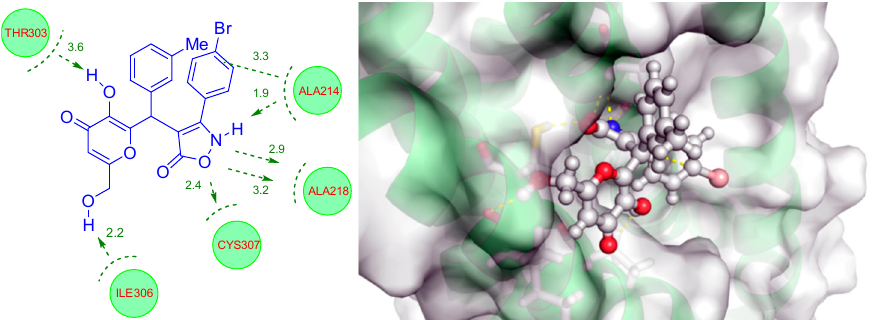
Figure 2. Interaction of compound 4 with the amino acids of C5a (arrows show the distances in angstrom between atoms).